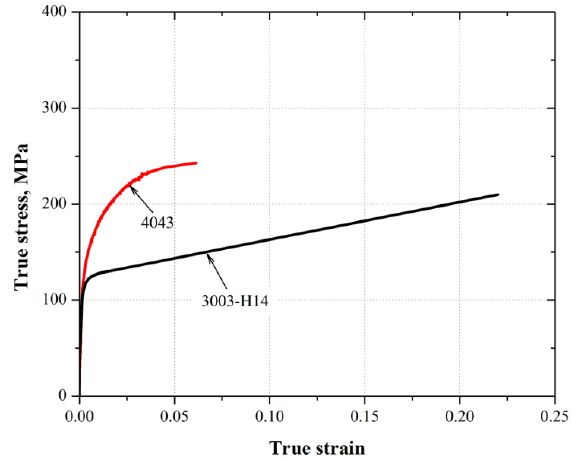
Figure 6. True stress–strain behavior for the 3003-H14 and 4043 aluminum alloys, data from